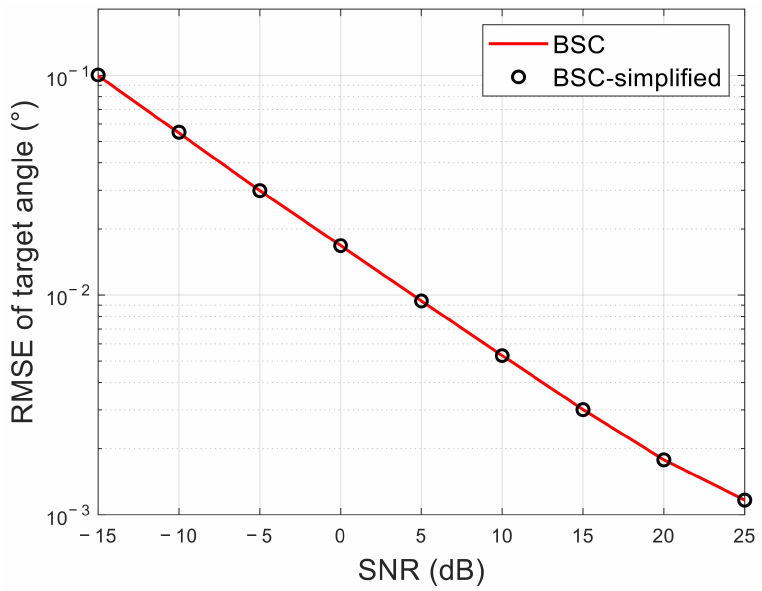
Figure 6. The RMSEs of the target angle for the BSC and simplified BSC algorithms against the SNR. Fourthly, the RMSE of the target angle for the BSC algorithm under different noise types is shown against the angle. For SNR = 15 dB and ρ = 0.9 exp ( j π ) , Figure 7 shows the RMSE of the target angle for the BSC algorithm against the angle, where the three noise types are Gaussian white noise with a mean value of zero, Gaussian white noise with a mean value of 0.1, and Gaussian colored noise with a mean value of zero, denoted by GW-0, GW-1, and GC, respectively. As can be observed, the BSC algorithm performs differently under various noise types. The estimation accuracy under colored noise is inferior to the estimation accuracy under white noise.